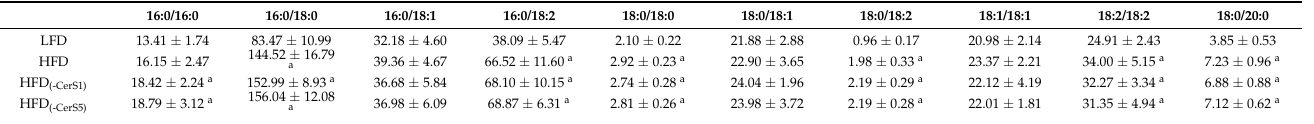
Table 3. Impact of CerS1 and CerS5 gene silencing on the content of individual diacylglycerol in mouse gastrocnemius muscle of HFD-fed animals. Values are mean pmol/mg of tissue ± SD; n = 8 per group; a — p < 0.05 vs. LFD.